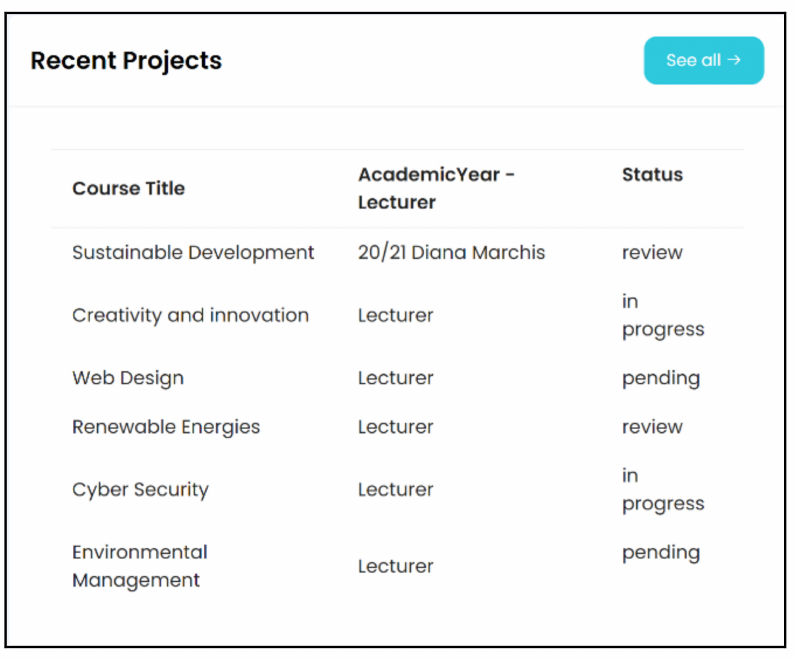
Figure 5. Responsive API EvalMathI—courses